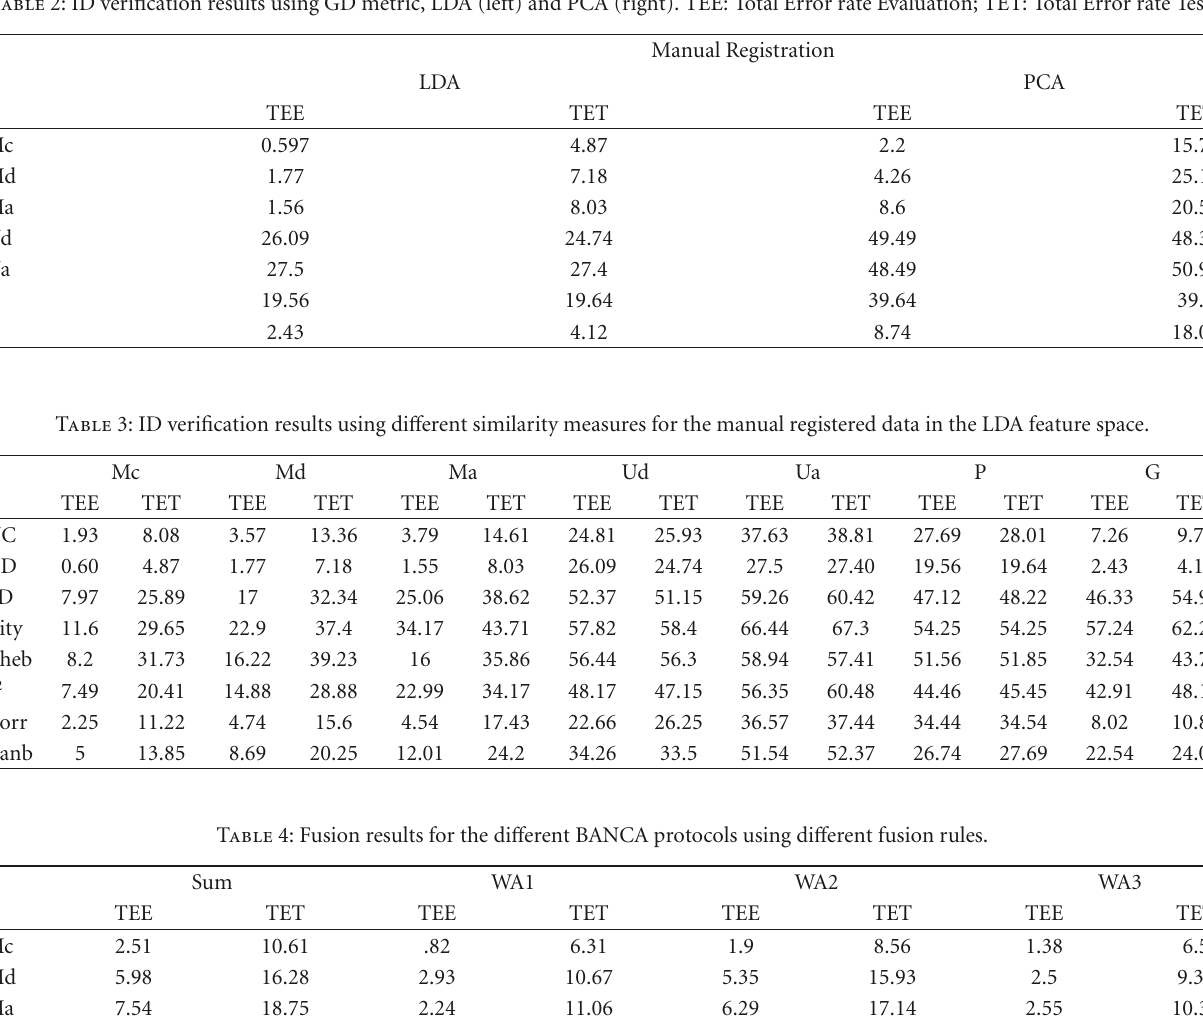
Table 2: ID verification results using GD metric, LDA (left) and PCA (right). TEE: Total Error rate Evaluation; TET: Total Error rate Test.